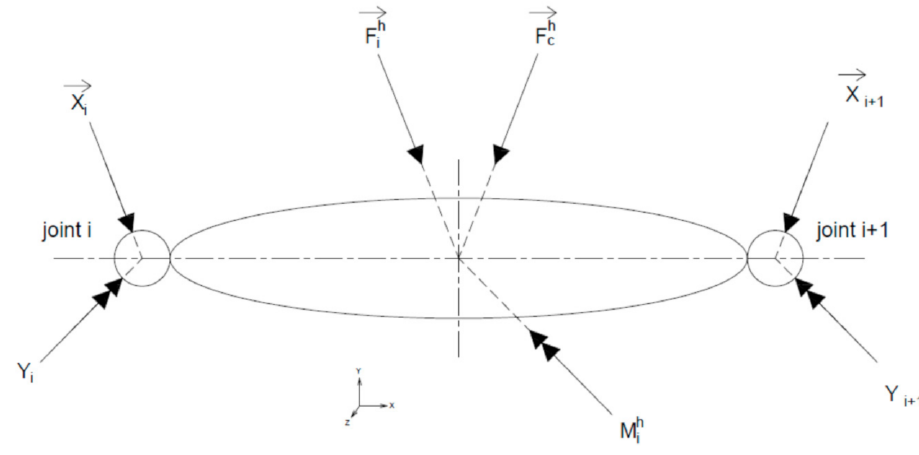
Figure 5. Applied forces and torques on a single sphroid, i.